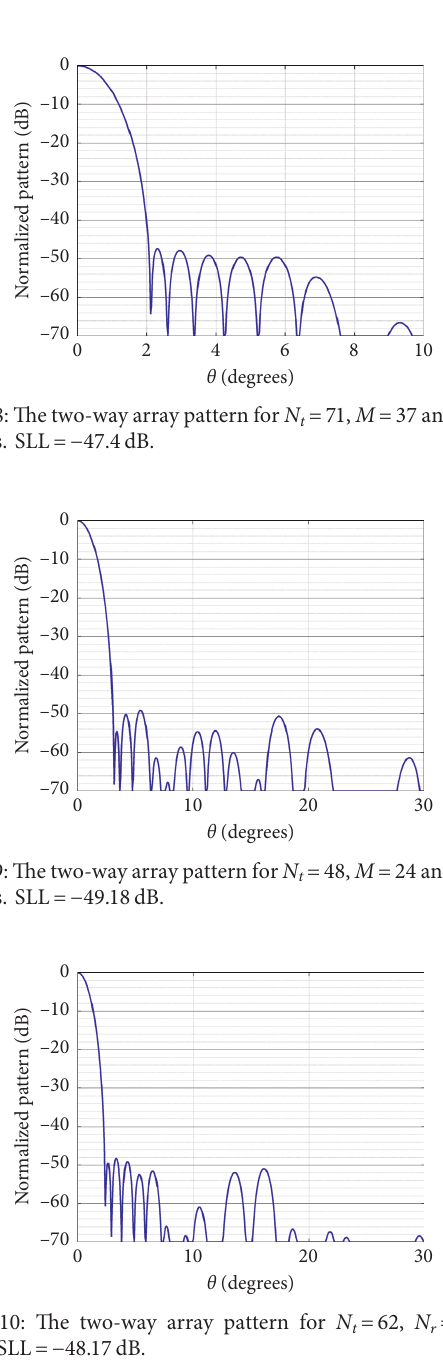
Figure 10: The two-way array pattern for N M � 32. SLL � − 48.17dB.